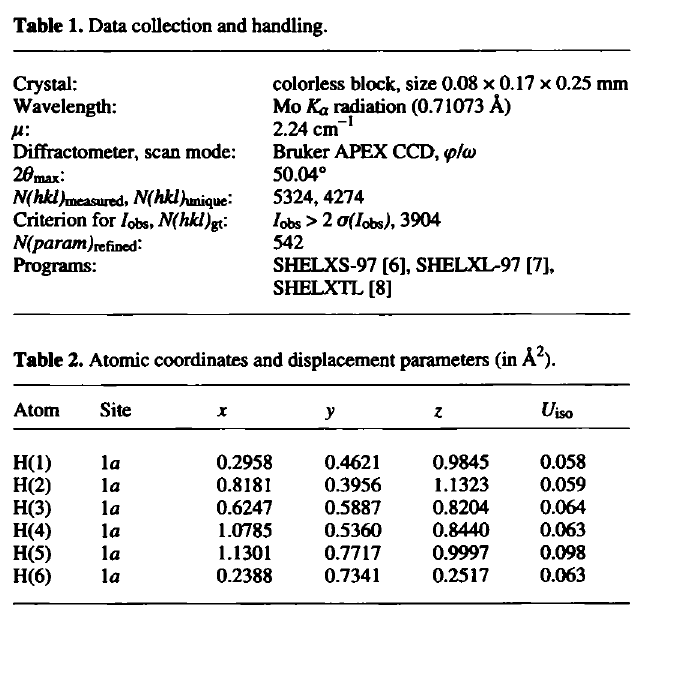
Table 1. Data collection and handling.